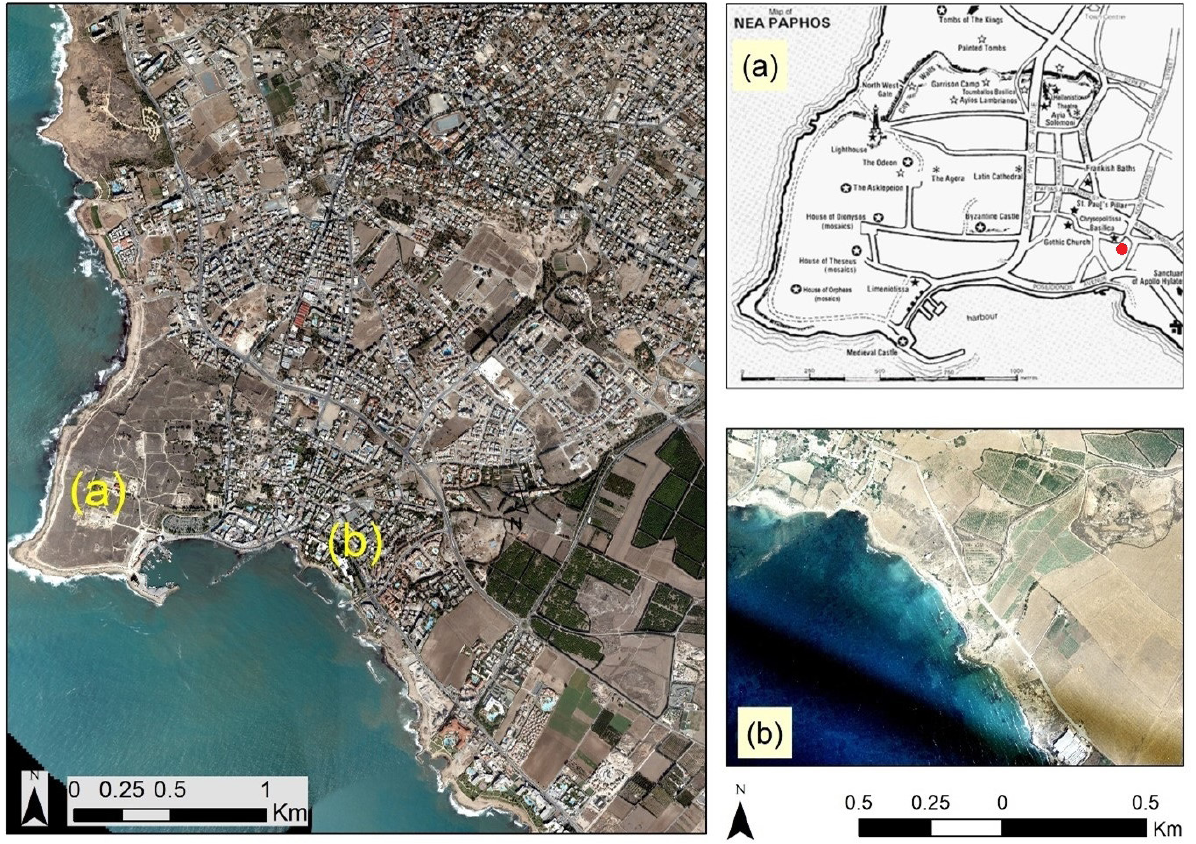
Figure 1: Left: The wider area of Paphos town in western Cyprus (Aerial Orthophoto 2014, Department of Land and Surveyors, Cyprus); (a): Map of Nea Paphos ancient city and suburbs (retrieved from Christou, 2008). The red dot shows an indicative starting point of the Eastern necropolis; (b): The Eastern necropolis of Nea Paphos seen in an archival aerial photograph of 1968 (Historic Environment